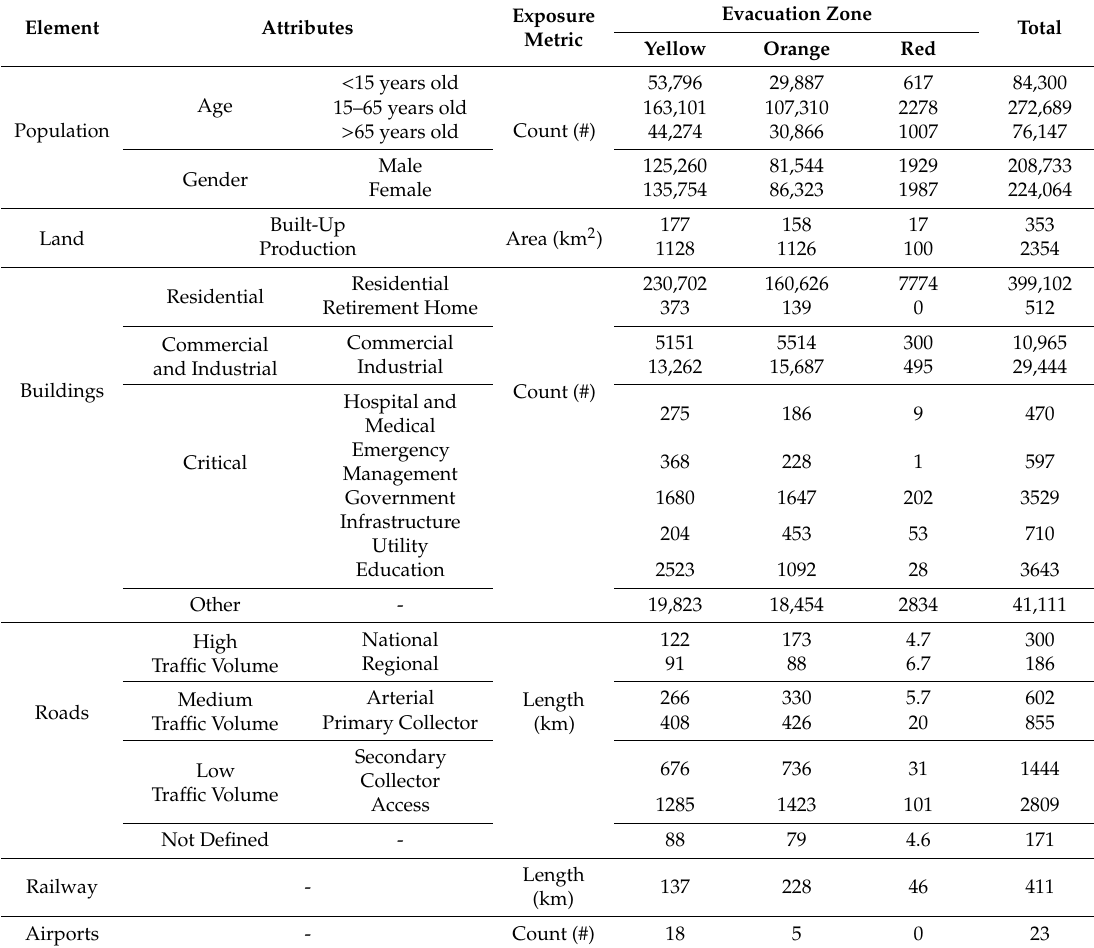
Table 2. National exposure estimates for population, built land and assets in tsunami evacuation zones. Exposure Element Attributes